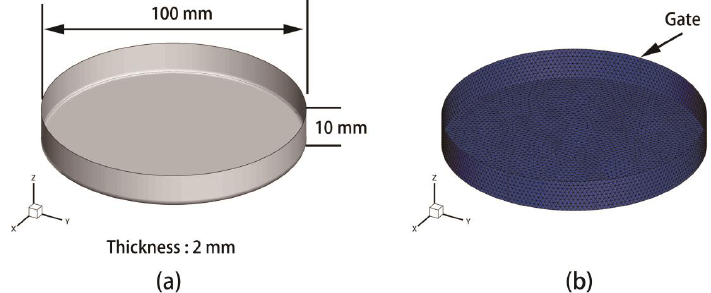
Figure 12. Polycarbonate light cover . ( a ) Geometry; ( b ) Finite element model.